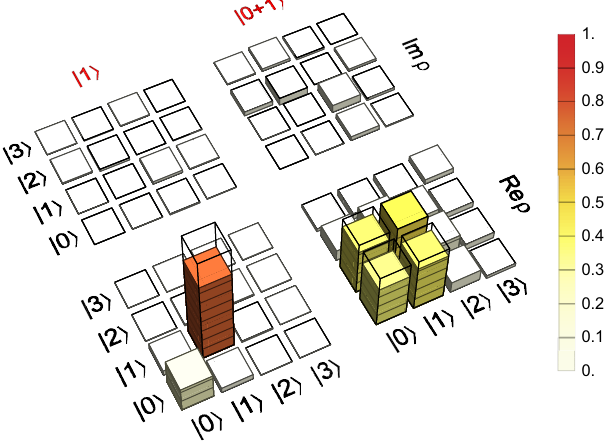
FIG. 3. The real and imaginary parts of the measured density matrices ρ of the symmetric temporal photon mode with fidelities F ¼ 76% and F ¼ 86% to the respective ideal states j 1 i and ffiffiffi p ðj 0 i þ j 1 iÞ = 2 . The wire frames show the single-photon Fock state j 1 i (all density matrix elements equal to 1 or 0) and the ideal ffiffiffi p 2 superposition state ðj 0 i þ j 1 iÞ = (all density matrix elements equal to 1 = 2 or 0). The ticks in the bars represent increments of